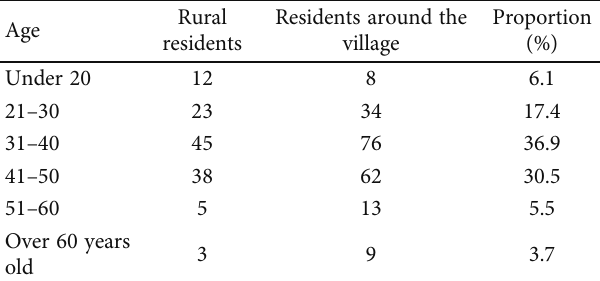
Table 2: Proportion of age.